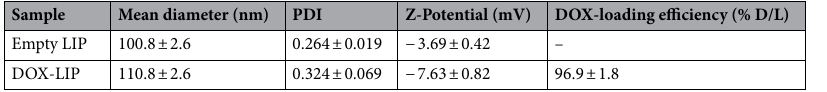
Table 1. Physicochemical properties of LIP and DOX-LIP with lipid composition DSPC/Chol/PEG (2:1:0.08 mol/mol/mol). Each value is the mean value calculated from three different preparations and the SD of each mean value is reported. Size values represent DLS intensity size